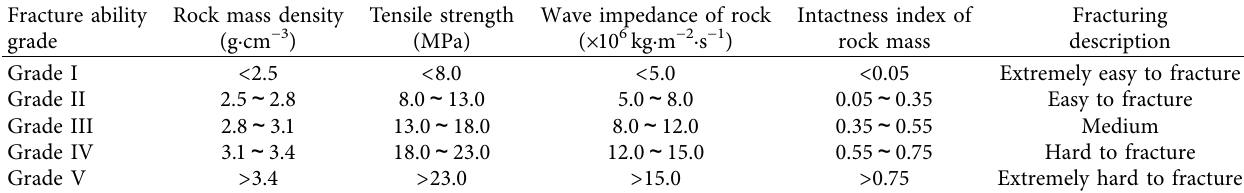
Table 2: Numerical scales of factor contribution.